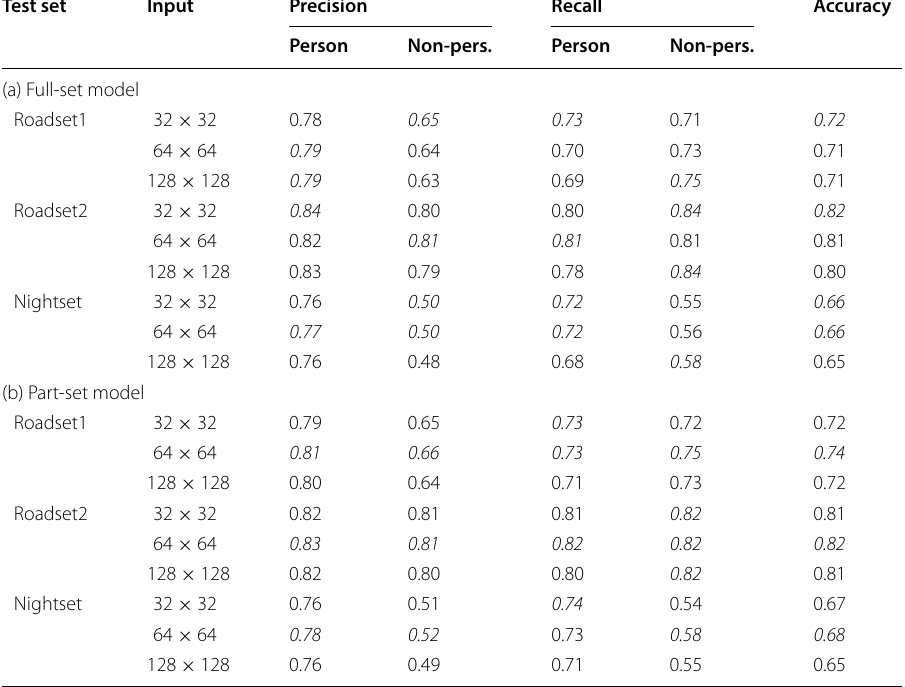
Table 6 Evaluation with different test datasets Test set Input Precision Recall Accuracy Person Non-pers.